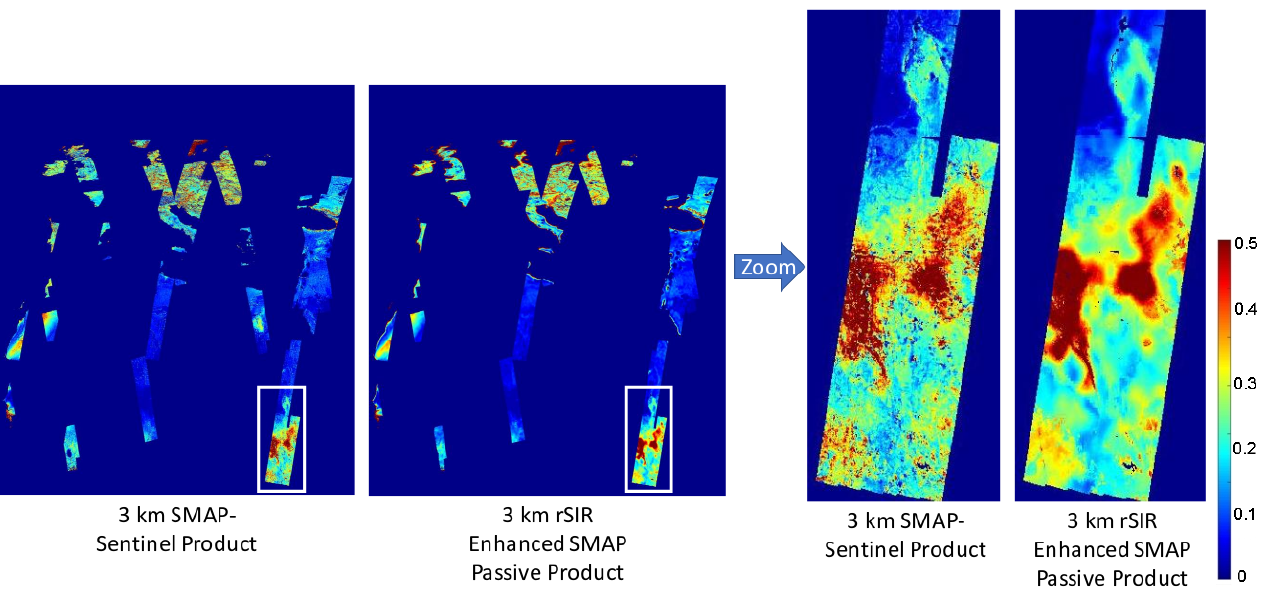
Figure 6. Soil moisture images in cm 3 cm − 3 for day 300 in 2016 from eastern Africa at 3 km pixel resolution comparing the SMAP-Sentinel merged product with the rSIR-enhanced passive soil moisture. The relative smoothness of the rSIR product is the result of its coarser